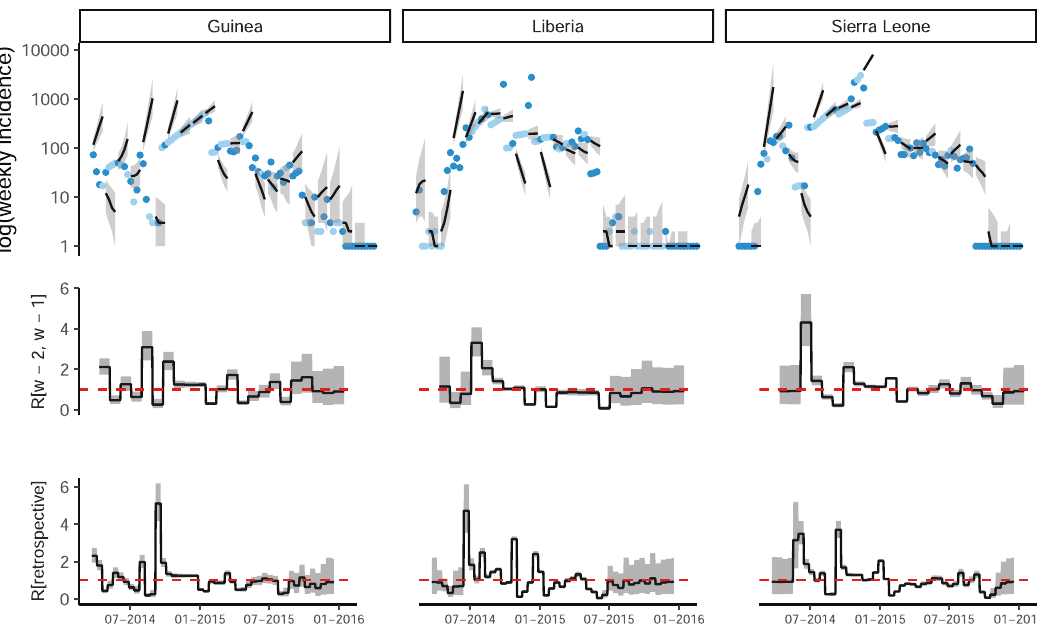
Fig. 4 Observed and predicted incidence, and reproduction number estimates from ProMED data. a The weekly incidence derived from ProMED data and the 4 weeks incidence forecast on log scale. The solid dots represent the observed weekly incidence where the light blue dots show weeks for which all data points were obtained using interpolation. The projections are made over 4 week windows, based on the reproduction number estimated in the previous 2 weeks. b The reproduction number used to make forecasts over each 4 week forecast horizon. c The effective reproduction number estimated retrospectively using the full dataset up to the length of one calibration window before the end. In each case, the solid black line is the median estimate and the shaded region represents the 95% Credible Interval. The red horizontal dashed line indicates the R t = 1 threshold. Results are shown for the three mainly affected countries although the analysis was done jointly using data for all countries in